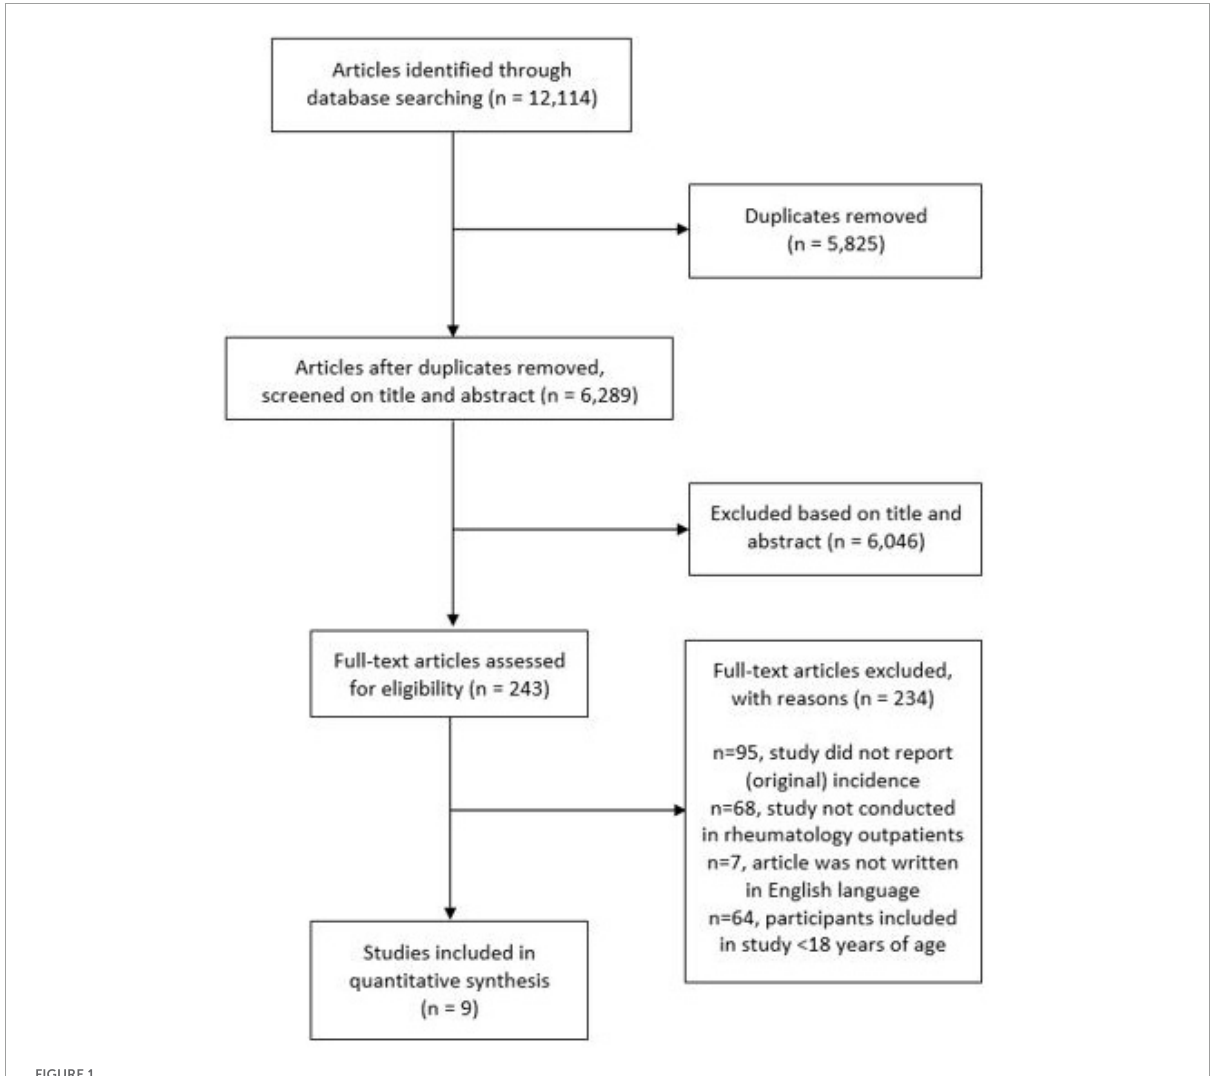
FIGURE1 Flow diagram of study